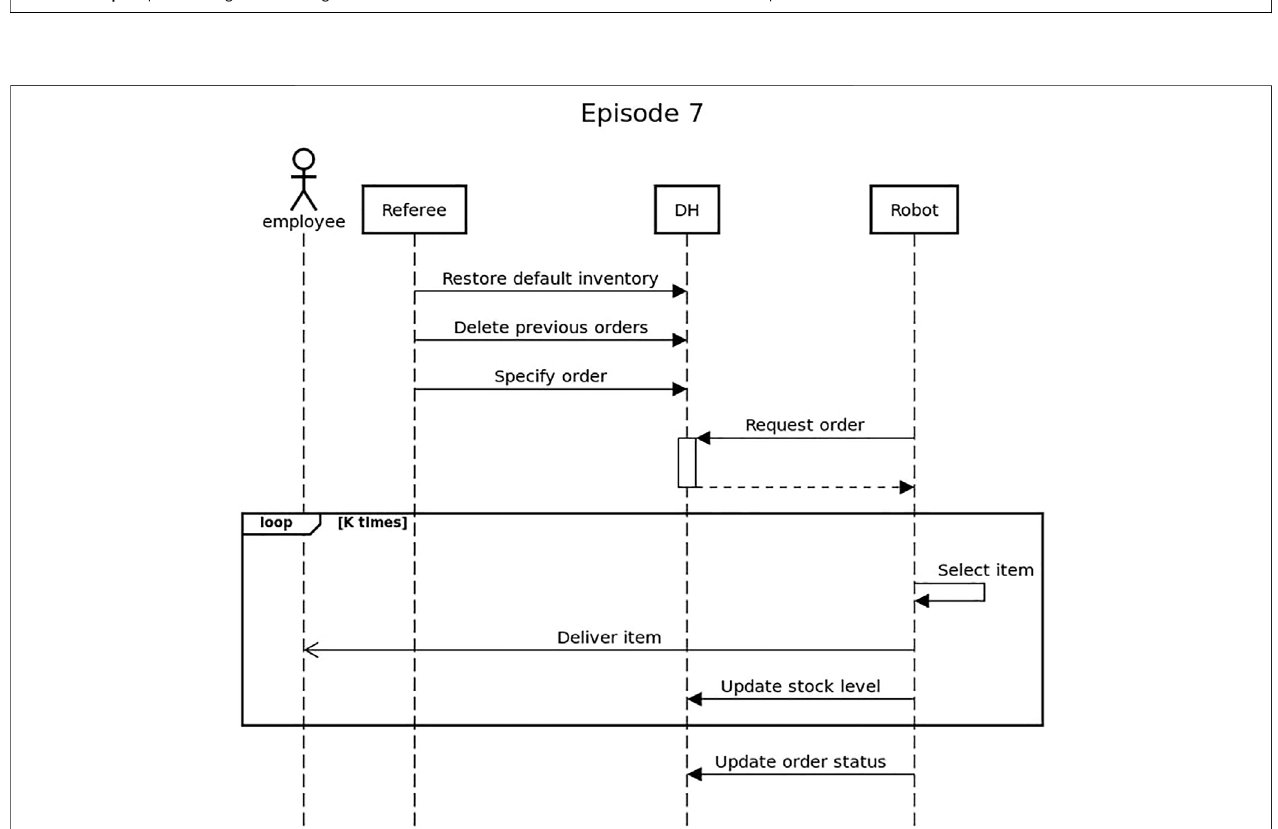
FIGURE 9 | Sequence diagram showing the interaction between the robot and the Data Hub for Episode 7